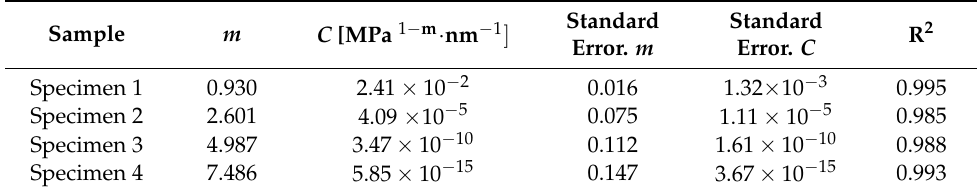
Figure 12. ( a ) Measured transmission efficiency for four specimens and ( b ) linear stiffness with respect to the contact pressure for all specimens with power-law fittings. Table 2. Constants C and m obtained for all